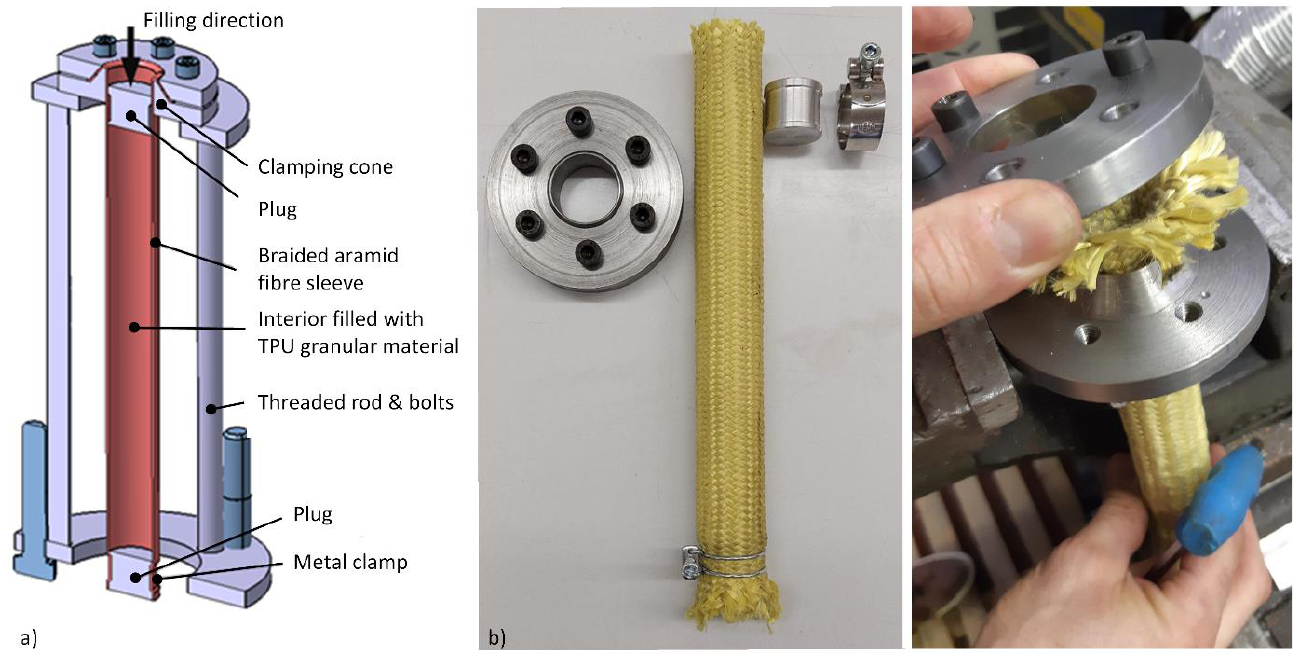
Figure 6. Detailed images of ( a ) the developed metal tool to prepare the granular specimens and ( b ) specimens preparation procedure. ( b ) specimens preparation